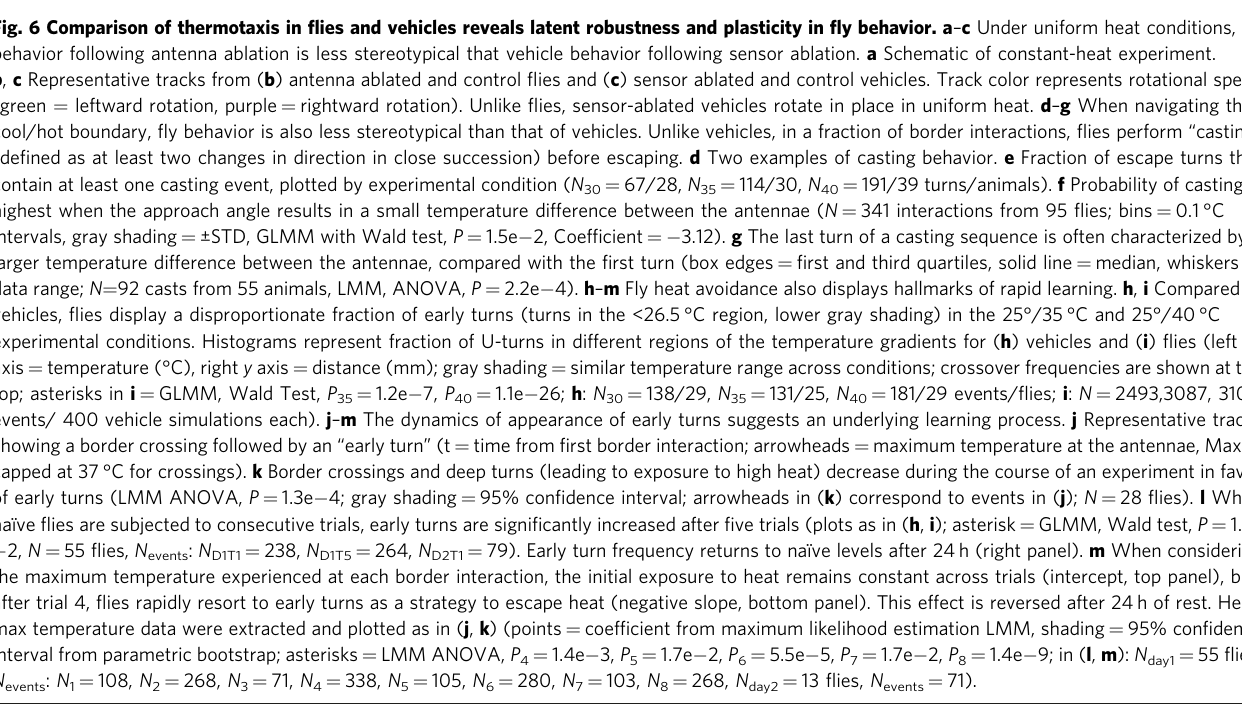
Fig. 6 Comparison of thermotaxis in fl ies and vehicles reveals latent robustness and plasticity in fl y behavior. a – c Under uniform heat conditions, fl y behavior following antenna ablation is less stereotypical that vehicle behavior following sensor ablation. a Schematic of constant-heat experiment. b , c Representative tracks from ( b ) antenna ablated and control fl ies and ( c ) sensor ablated and control vehicles. Track color represents rotational speed (green = leftward rotation, purple = rightward rotation). Unlike fl ies, sensor-ablated vehicles rotate in place in uniform heat. d – g When navigating the cool/hot boundary, fl y behavior is also less stereotypical than that of vehicles. Unlike vehicles, in a fraction of border interactions, fl ies perform “ casting ” (de fi ned as at least two changes in direction in close succession) before escaping. d Two examples of casting behavior. e Fraction of escape turns that contain at least one casting event, plotted by experimental condition ( N 30 = 67/28, N 35 = 114/30, N 40 = 191/39 turns/animals). f Probability of casting is highest when the approach angle results in a small temperature difference between the antennae ( N = 341 interactions from 95 fl ies; bins = 0.1 °C intervals, gray shading = ±STD, GLMM with Wald test, P = 1.5e − 2, Coef fi cient = − 3.12). g The last turn of a casting sequence is often characterized by a larger temperature difference between the antennae, compared with the fi rst turn (box edges = fi rst and third quartiles, solid line = median, whiskers = data range; N = 92 casts from 55 animals, LMM, ANOVA, P = 2.2e − 4). h – m Fly heat avoidance also displays hallmarks of rapid learning. h , i Compared to vehicles, fl ies display a disproportionate fraction of early turns (turns in the <26.5 °C region, lower gray shading) in the 25°/35 °C and 25°/40 °C experimental conditions. Histograms represent fraction of U-turns in different regions of the temperature gradients for ( h ) vehicles and ( i ) fl ies (left y - axis = temperature (°C), right y axis = distance (mm); gray shading = similar temperature range across conditions; crossover frequencies are shown at the top; asterisks in i = GLMM, Wald Test, P 35 = 1.2e − 7, P 40 = 1.1e − 26; h : N 30 = 138/29, N 35 = 131/25, N 40 = 181/29 events/ fl ies; i : N = 2493,3087, 3109 events/ 400 vehicle simulations each). j – m The dynamics of appearance of early turns suggests an underlying learning process. j Representative tracks showing a border crossing followed by an “ early turn ” (t = time from fi rst border interaction; arrowheads = maximum temperature at the antennae, Max T, capped at 37 °C for crossings). k Border crossings and deep turns (leading to exposure to high heat) decrease during the course of an experiment in favor of early turns (LMM ANOVA, P = 1.3e − 4; gray shading = 95% con fi dence interval; arrowheads in ( k ) correspond to events in ( j ); N = 28 fl ies). l When naïve fl ies are subjected to consecutive trials, early turns are signi fi cantly increased after fi ve trials (plots as in ( h , i ); asterisk = GLMM, Wald test, P = 1.3e − 2, N = 55 fl ies, N N = 238, N = 264, N = 79). Early turn frequency returns to naïve levels after 24 h (right panel). m When considering events : D1T1 D1T5 D2T1 the maximum temperature experienced at each border interaction, the initial exposure to heat remains constant across trials (intercept, top panel), but, after trial 4, fl ies rapidly resort to early turns as a strategy to escape heat (negative slope, bottom panel). This effect is reversed after 24 h of rest. Here, max temperature data were extracted and plotted as in ( j , k ) (points = coef fi cient from maximum likelihood estimation LMM, shading = 95% con fi dence interval from parametric bootstrap; asterisks = LMM ANOVA, P 4 = 1.4e − 3, P 5 = 1.7e − 2, P 6 = 5.5e − 5, P 7 = 1.7e − 2, P 8 = 1.4e − 9; in ( l , m ): N day1 = 55 fl ies,